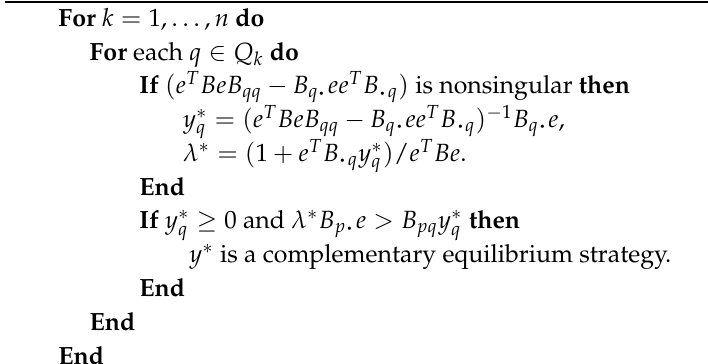
Algorithm 4: A Complete Complementary Shapley-Snow Algorithm